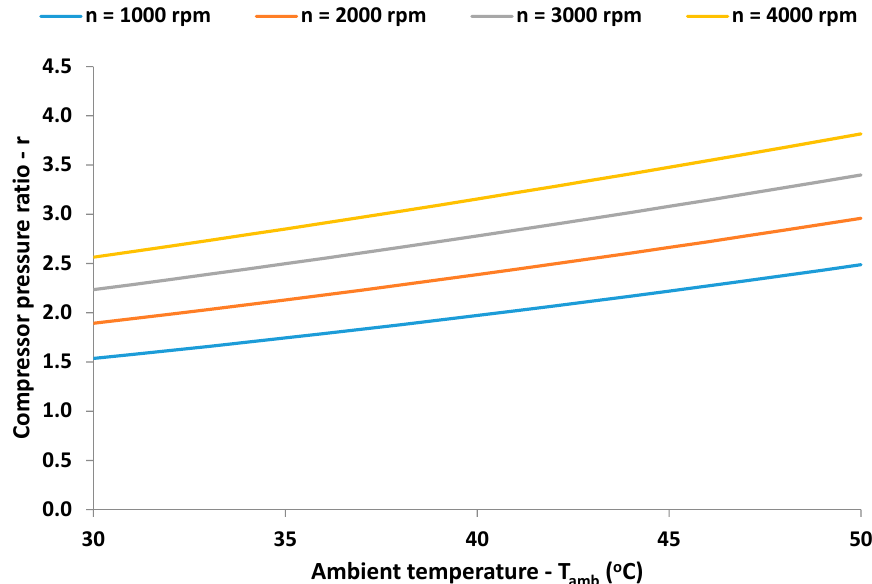
Figure 7. Cooling capacity for different ambient temperatures and rotational speeds ( T ind = 25 °C).